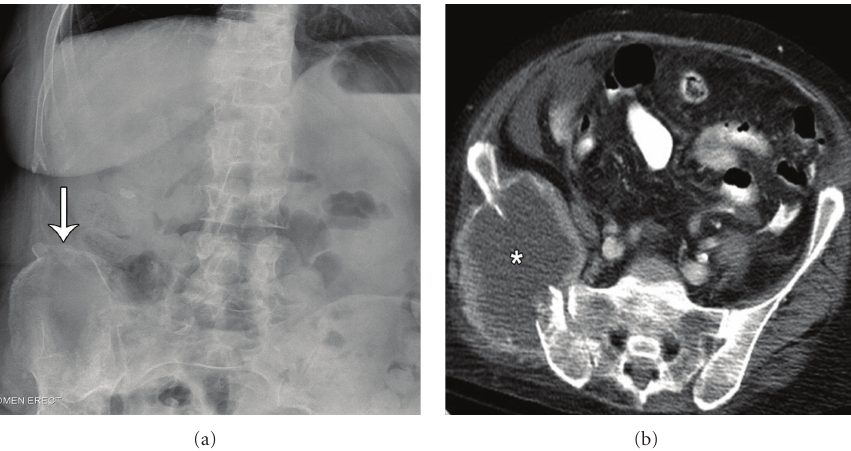
Figure 1: Middle-aged female presents with chronic pelvic pain. Frontal radiograph (a) of the abdomen reveals subtle cortical disruption and periosteal reaction involving the superior aspect of the right iliac crest (arrow). Subsequent CT examination (b) demonstrates a lytic destructive lesion of the right iliac bone, with a large soft tissue mass (asterisk).